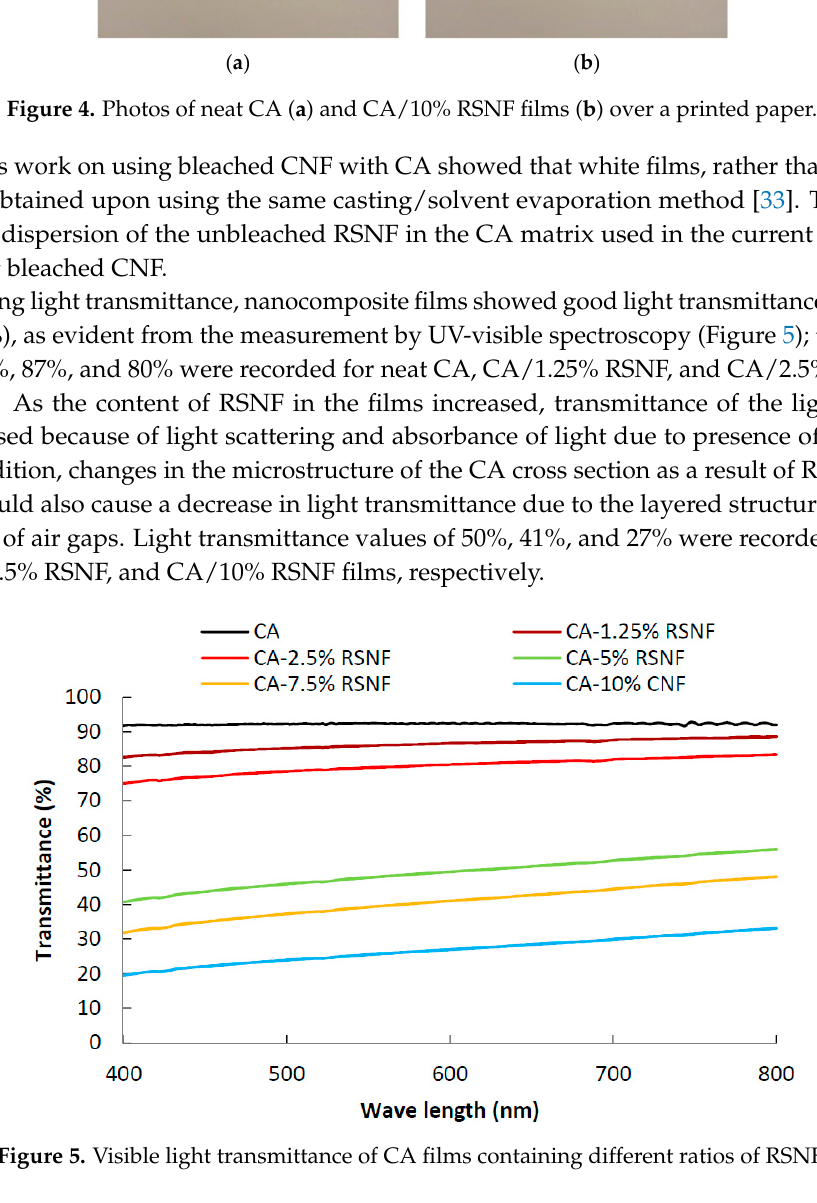
Figure 5. Visible light transmittance of CA films containing different ratios of RSNF.